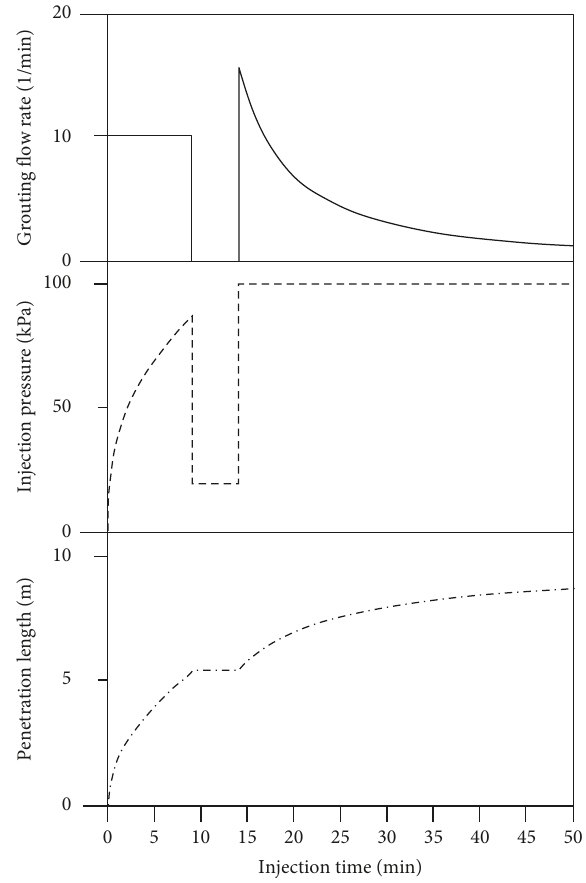
Figure 3: Grout evolution following alternating pressure control and flow rate control.